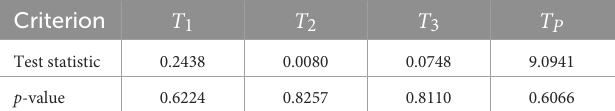
TABLE 7 Test values of test statistics and their corresponding p -values for the data in Table 6 when testing for the exponential model. Criterion